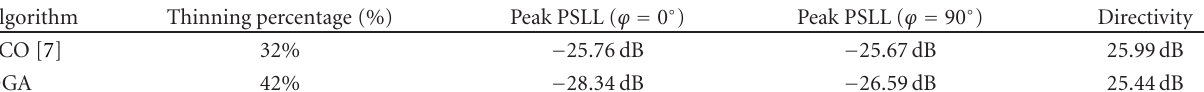
Table 6: Comparison with the ACO [7] for the planar array.